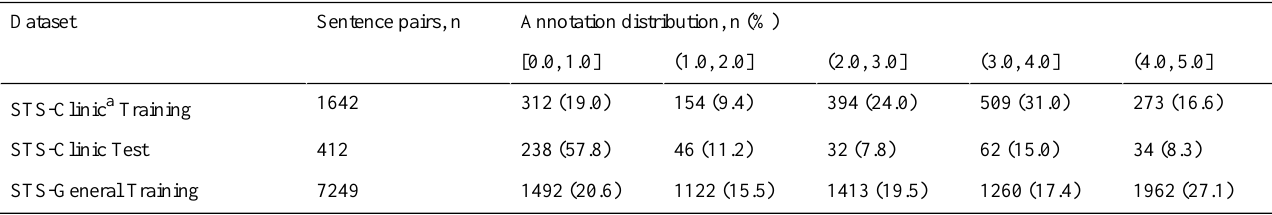
Table 1. Descriptive statistics of the datasets.